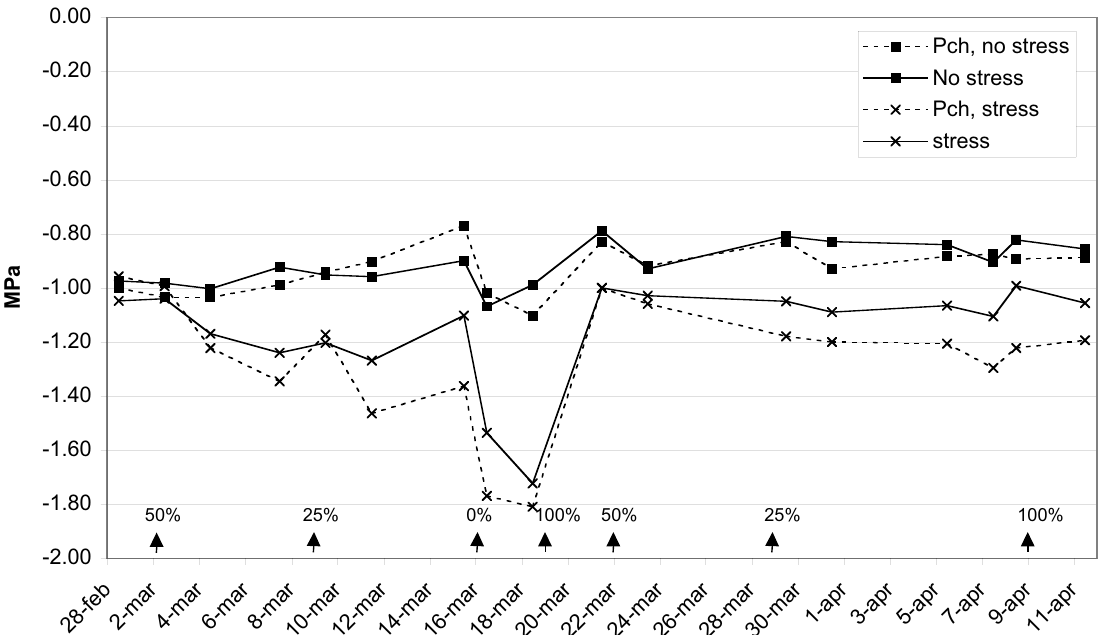
Fig. 7. Impact of P. chlamydospora infection on response of potted Zinfandel grapevines to water stress, as measured by leaf water potential at 3 pm, Year 2,